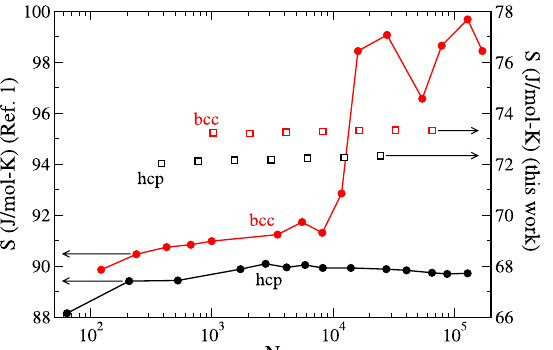
Figure 1. Entropy for bcc (red) and hcp (black) phases of iron as a function of simulated-system size at 360 GPa and 7000 K. Filled symbols joined by lines (left axis) are results from (I); open symbols (right axis) are results computed here, with estimated stochastic + systematic errors that are smaller than symbol size. Note that left and right axes are shifted with respect to each other, but cover the same range (12